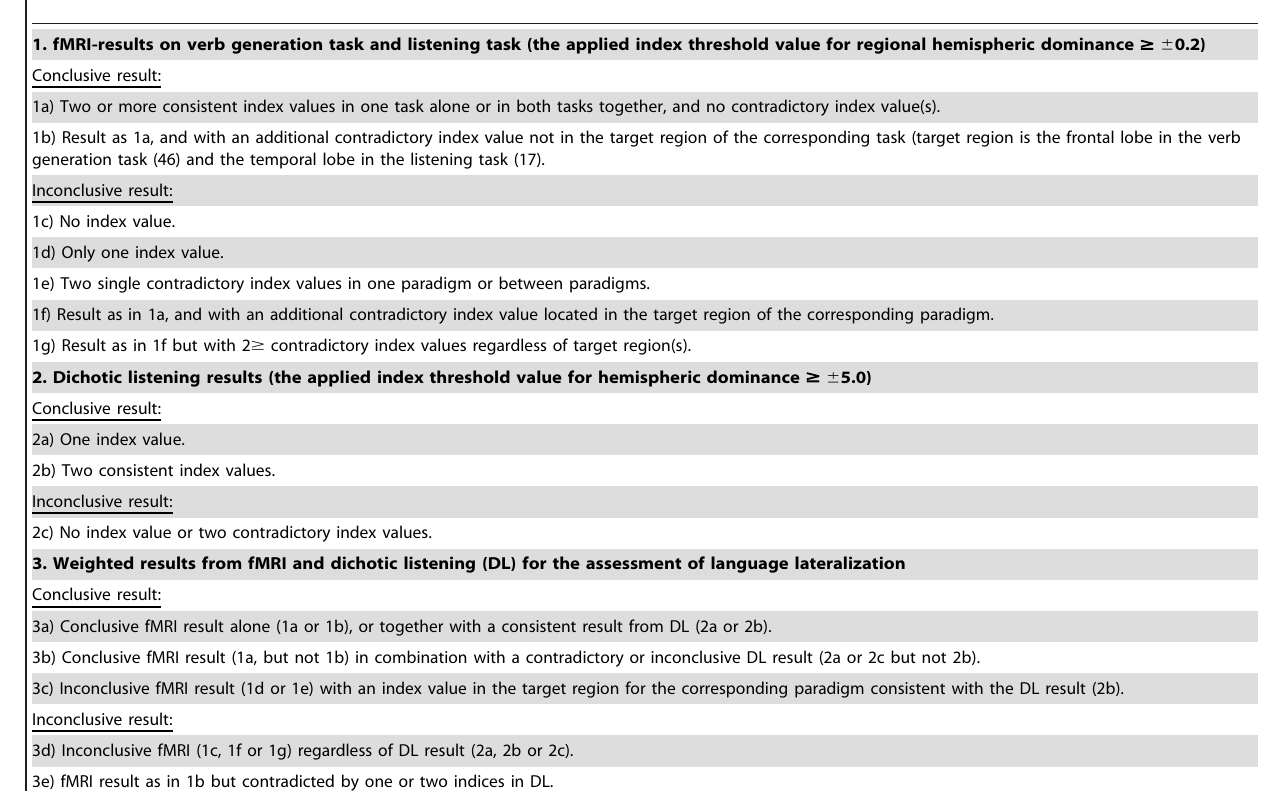
Table 1. The criteria applied in the analysis of the fMRI data (1.), and of the dichotic listening data (2.), and the criteria used to combine these two analyses to reach a final conclusion about hemispheric language dominance (3.).